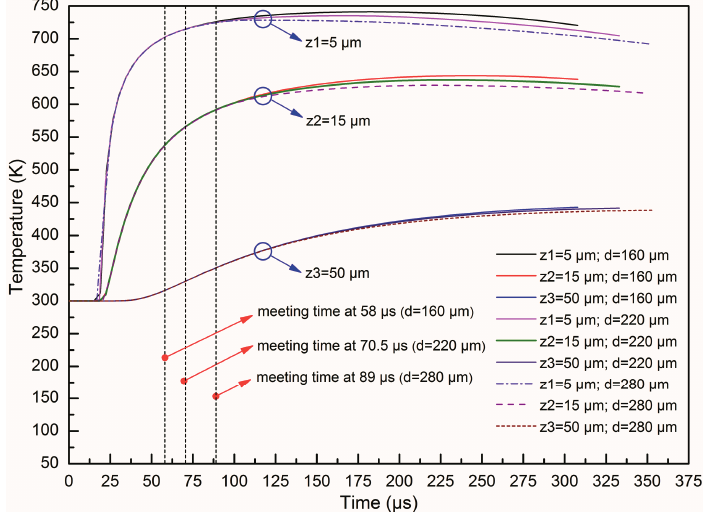
Figure 10. Temperature history at specific position during the impact of successive